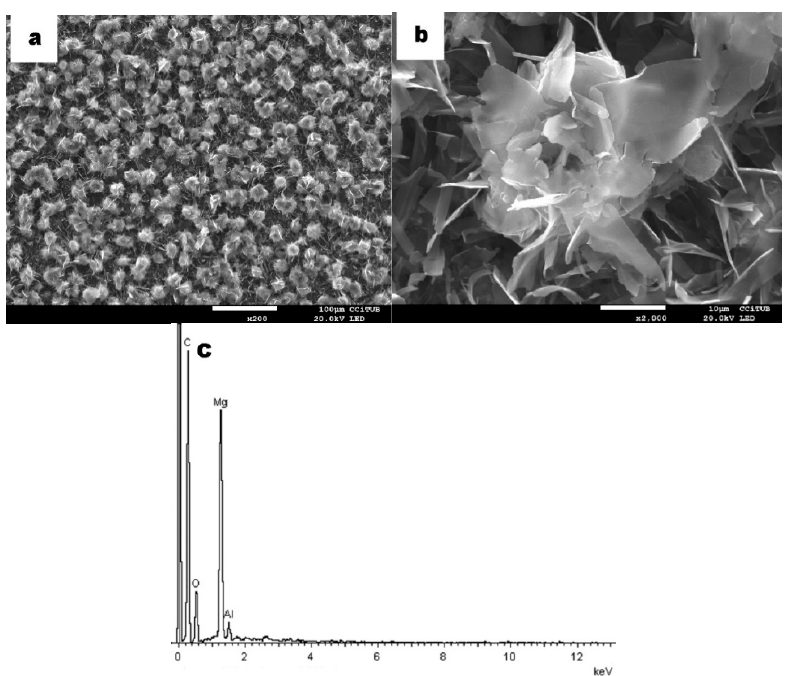
Figure 1 . FE-SEM images of the as-prepared superhydrophobic (SH) surface on aluminum substrate: ( a ) distribution of microstructures on the substrate after 900 s of electrodeposition; ( b ) at higher magnification the flower-like structure and its nanostructured layers are observable; and ( c ) EDS microanalysis where Mg and C from the obtained coating and Al from substrate can be identified.